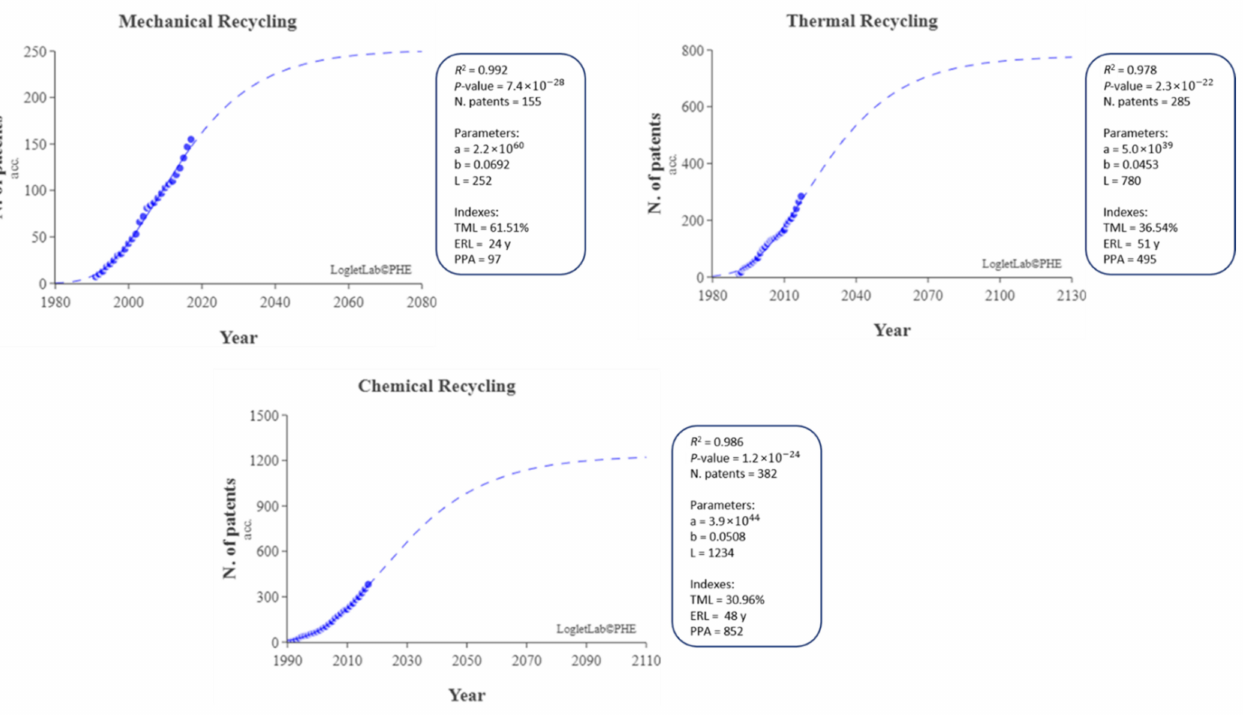
Figure 4. Gompertz growth curve and its parameters for mechanical, thermal, and chemical recycling